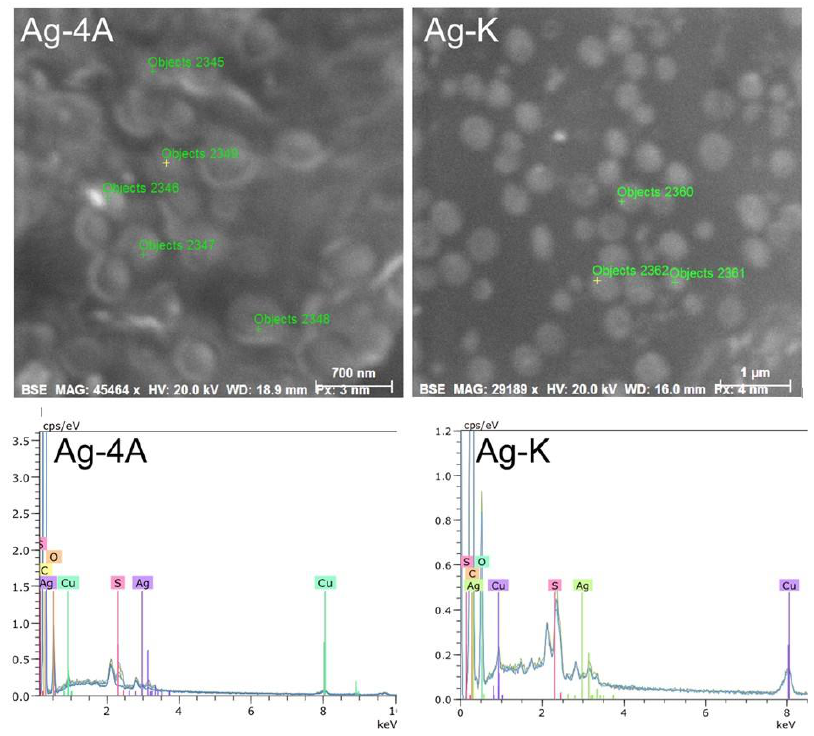
Figure 7. Black spots observed in TEM and analyzed by EDS-SEM for composition.